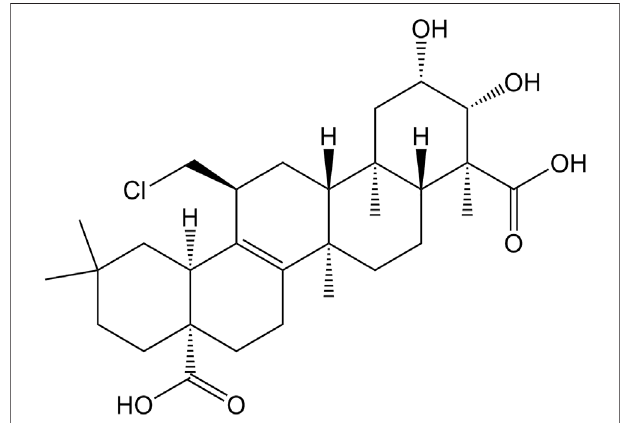
FIGURE 1 | The molecular structure of